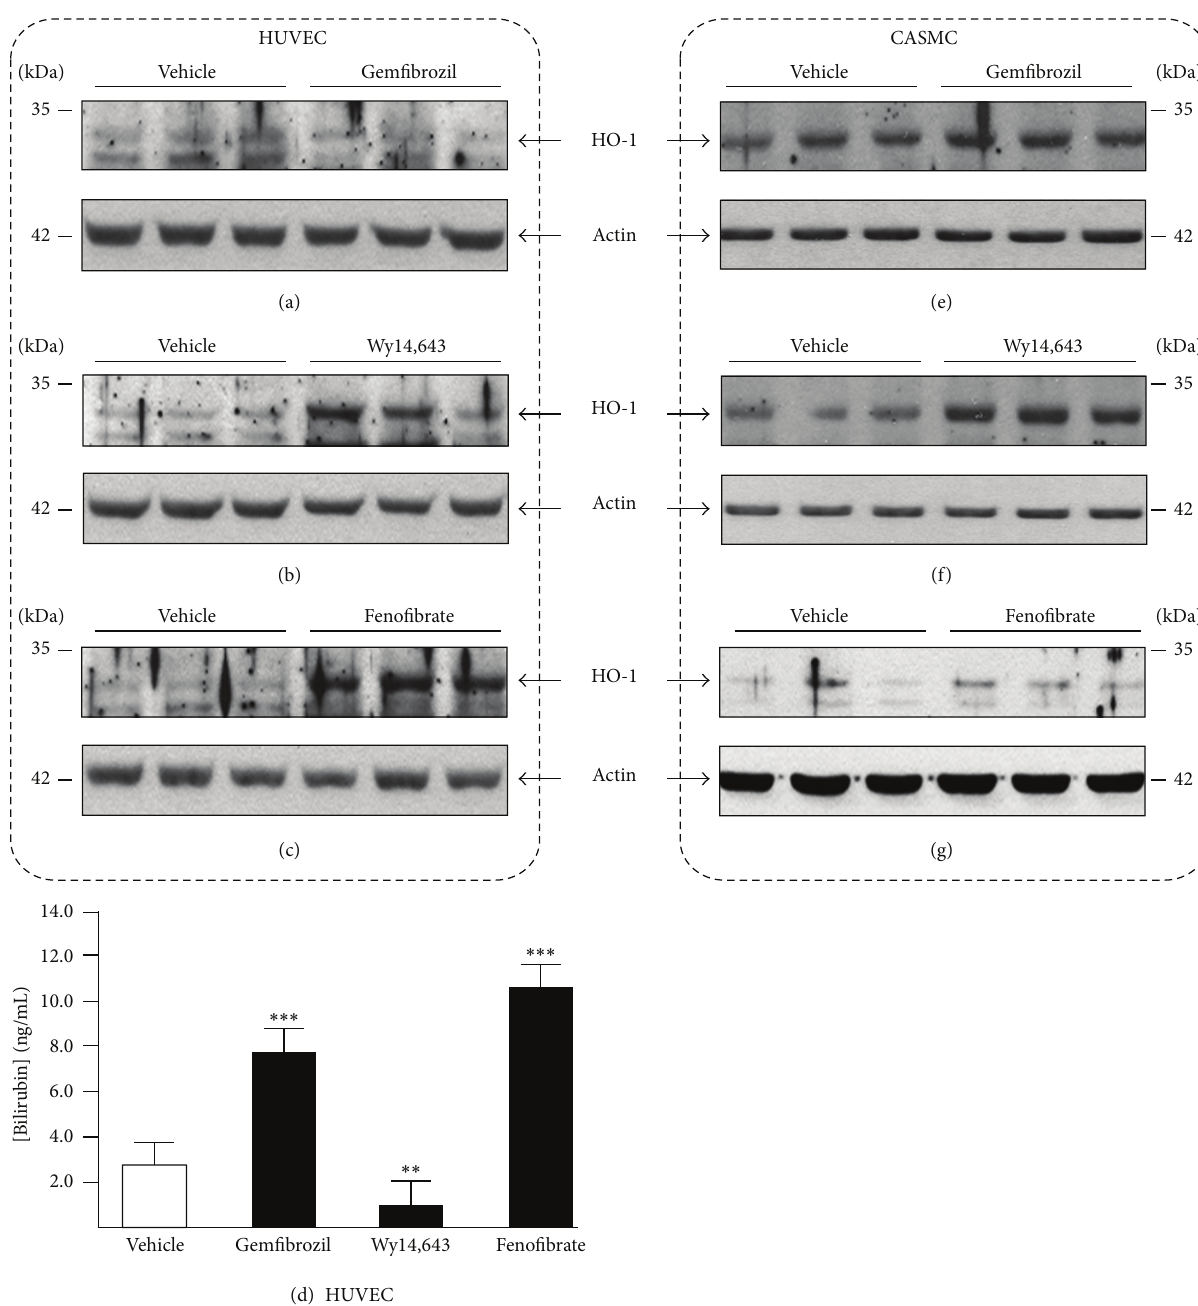
Figure 4: PPAR 𝛼 ligands differentially affect HO-1 protein levels and/or bilirubin secretion in human umbilical vein endothelial cells (HUVEC) and coronary artery smooth muscle cells (CASMC). HUVECs (a–d) and CASMCs (e–g) were cultured in the presence of vehicle (DMSO, 0.1%, v/v), 250 𝜇 M gemfibrozil (a, d, and e), 75 𝜇 M Wy14,643 (b, d, and f), or 250 𝜇 M fenofibrate (c, d, and g) for 48H. ((a–c) and (e–g)) HO-1 protein levels were visualized in cell homogenates (20 𝜇 g–25 𝜇 g) through immunoblotting using the anti-HO-1 (1: 400 dilution) antibody. The same membranes were subsequently hybridized with an anti-actin antibody (1:2,000 dilution) to ensure the equal loading of each lane. (d) Bilirubin concentration was determined in culture media through liquid chromatography coupled to tandem